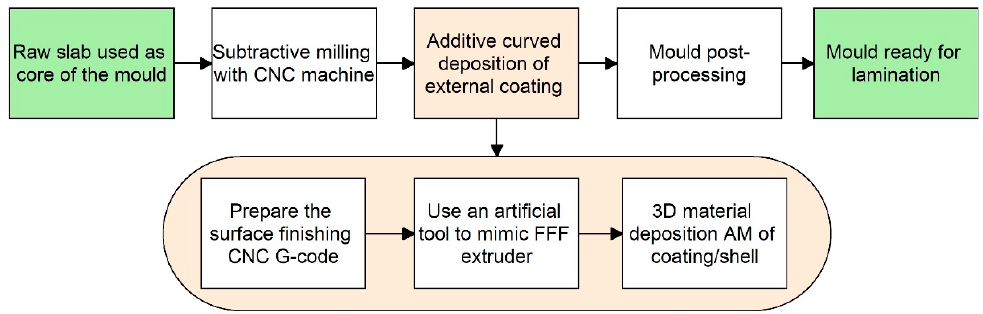
Figure 2. Graphical representation of the hybrid manufacturing framework described in this re ‐ search.